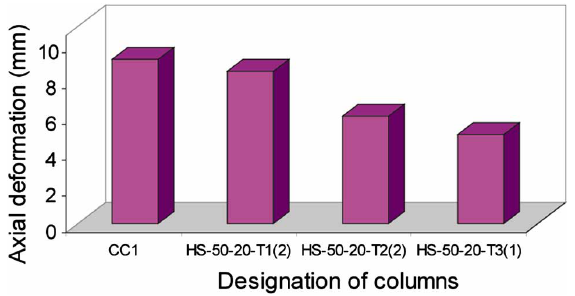
Fig. 14. Axial deformation of columns HS-50-20 (cid:1) comparison